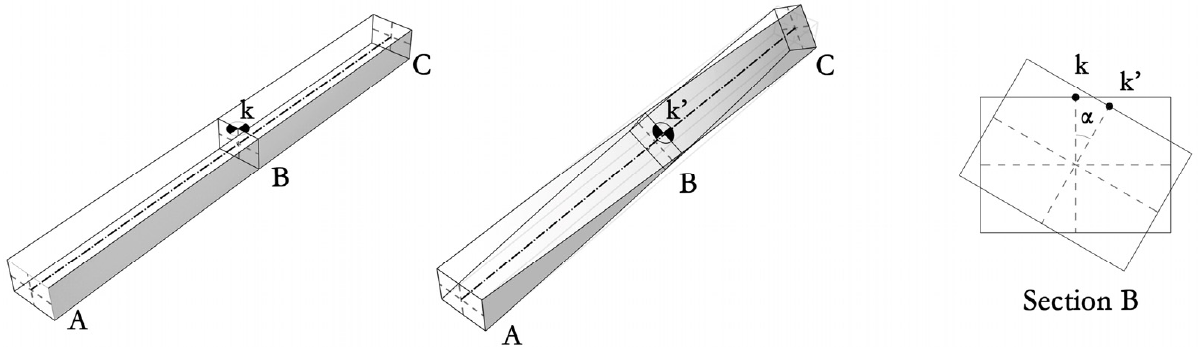
Figure 9. Movement of a deformation control point (k) due exclusively to torsion in the lath.